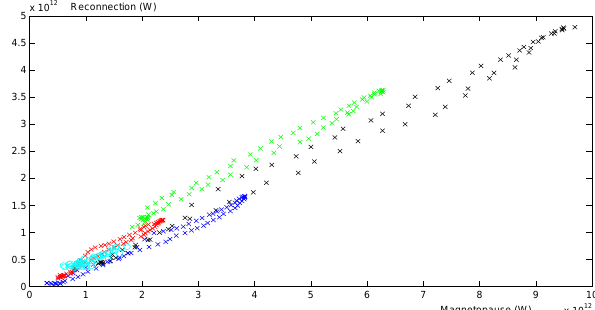
Fig. 11. Magnetotail reconnection power versus simultaneous en- ergy flux through the magnetopause in Gumics-4. Crosses are from the four synthetic IMF rotation runs, coloured as in Fig. 8. Circles are from the 15 August 2001 substorm